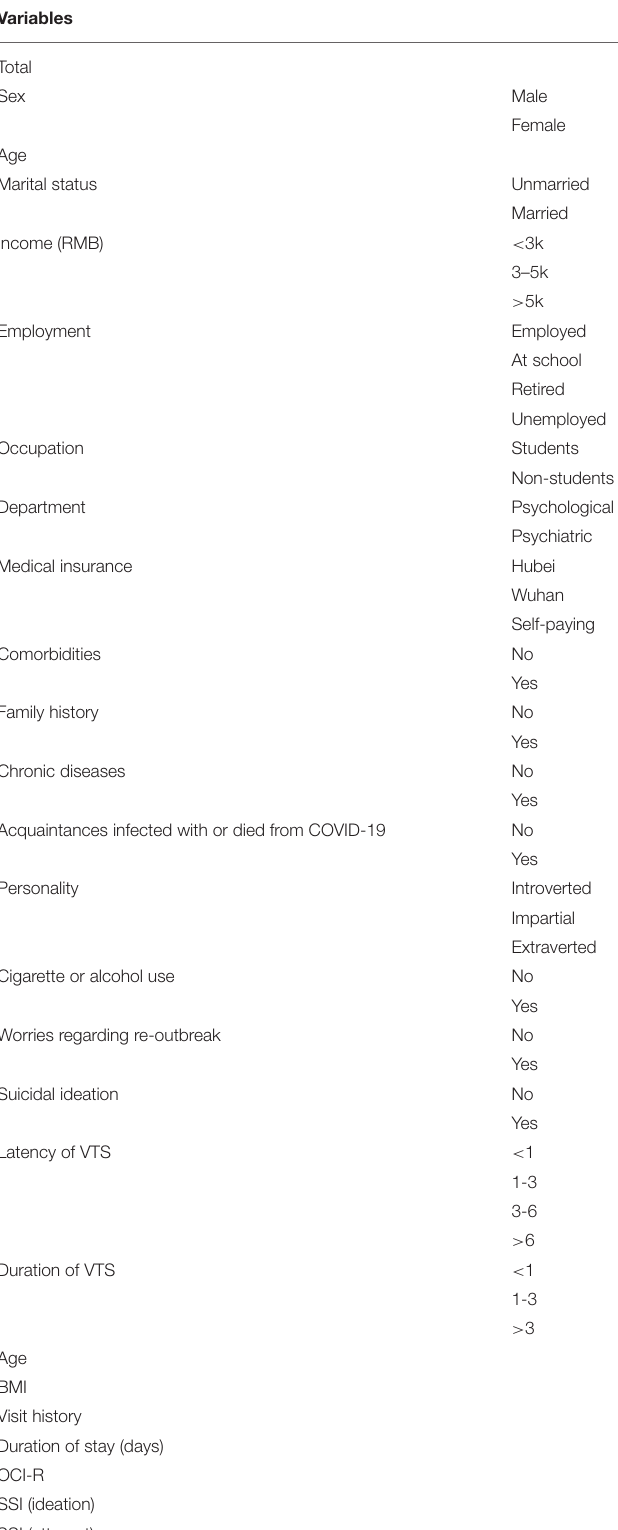
TABLE 3 | Comparison of mental health status between respondents with or without pVT.